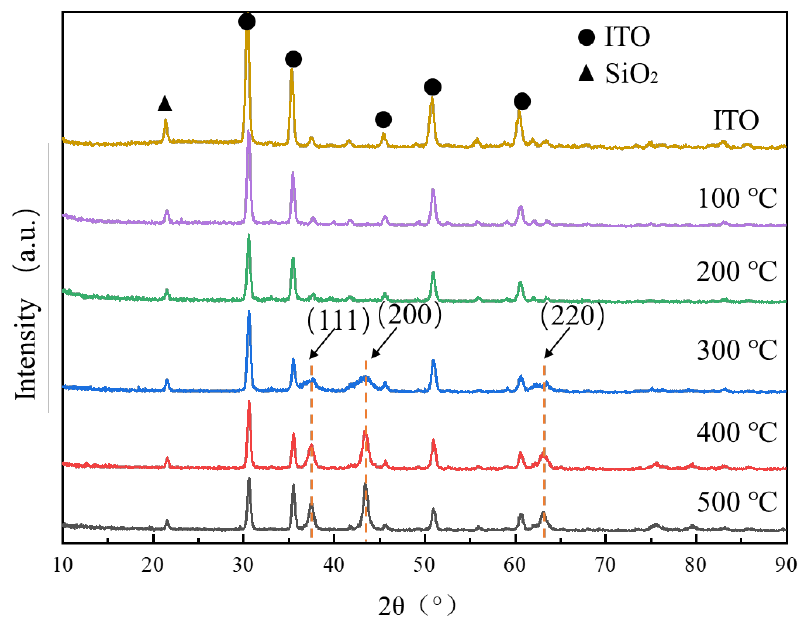
Figure 4. XRD patterns of NiO films annealed at different temperature.